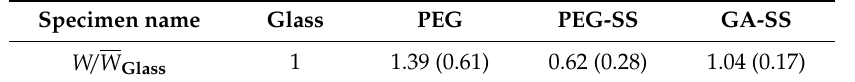
Table 3. Ratio of the frost weights to the average frost weight for uncoated glasses.